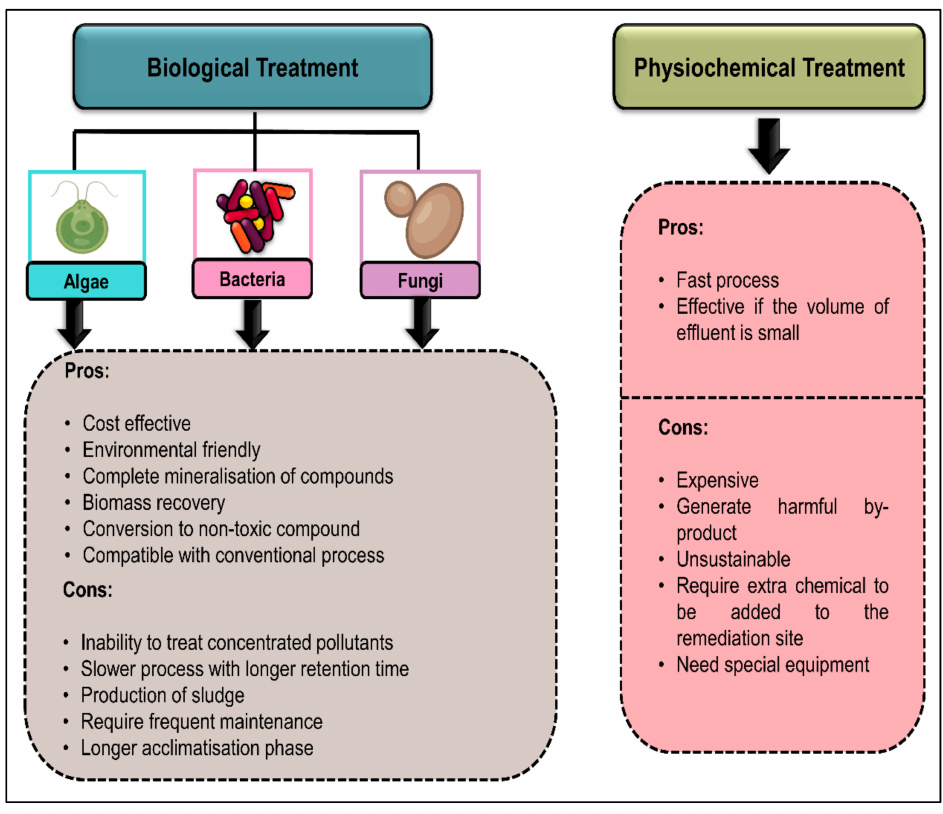
Figure 8. The comparison between biological and physiochemical treatment as described by [10,21,51,54]. Figure 7 also highlights that “algae” is the basic and transversal theme. This cluster theme was illustrated as a theme with low density (0.50) and high centrality value (1); hence, the themes possess greater impact yet slower evolution in the research field (Table